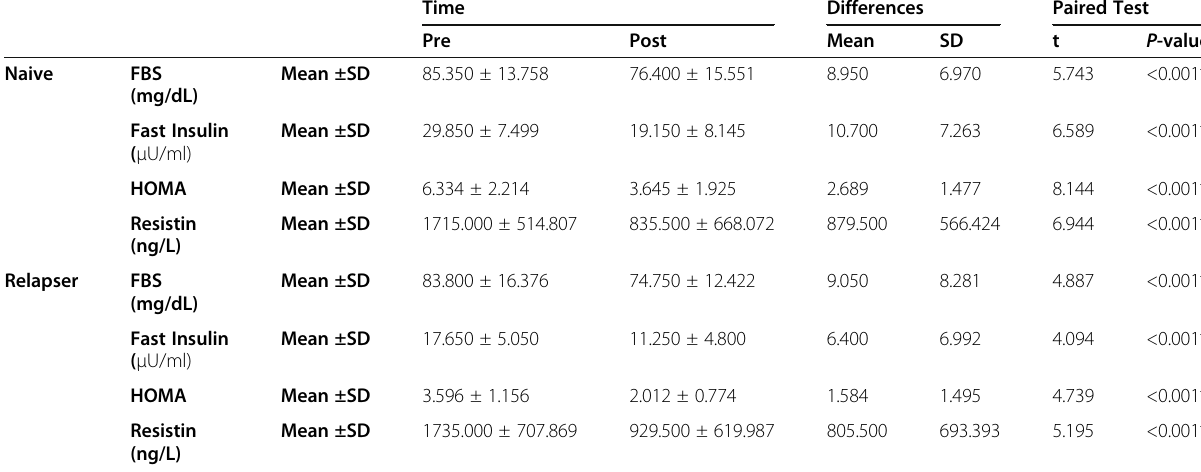
Table 4 Comparison between baseline & post-treatment fasting blood sugar, fasting insulin, HOMA-IR & resistin in naive and relapser group of